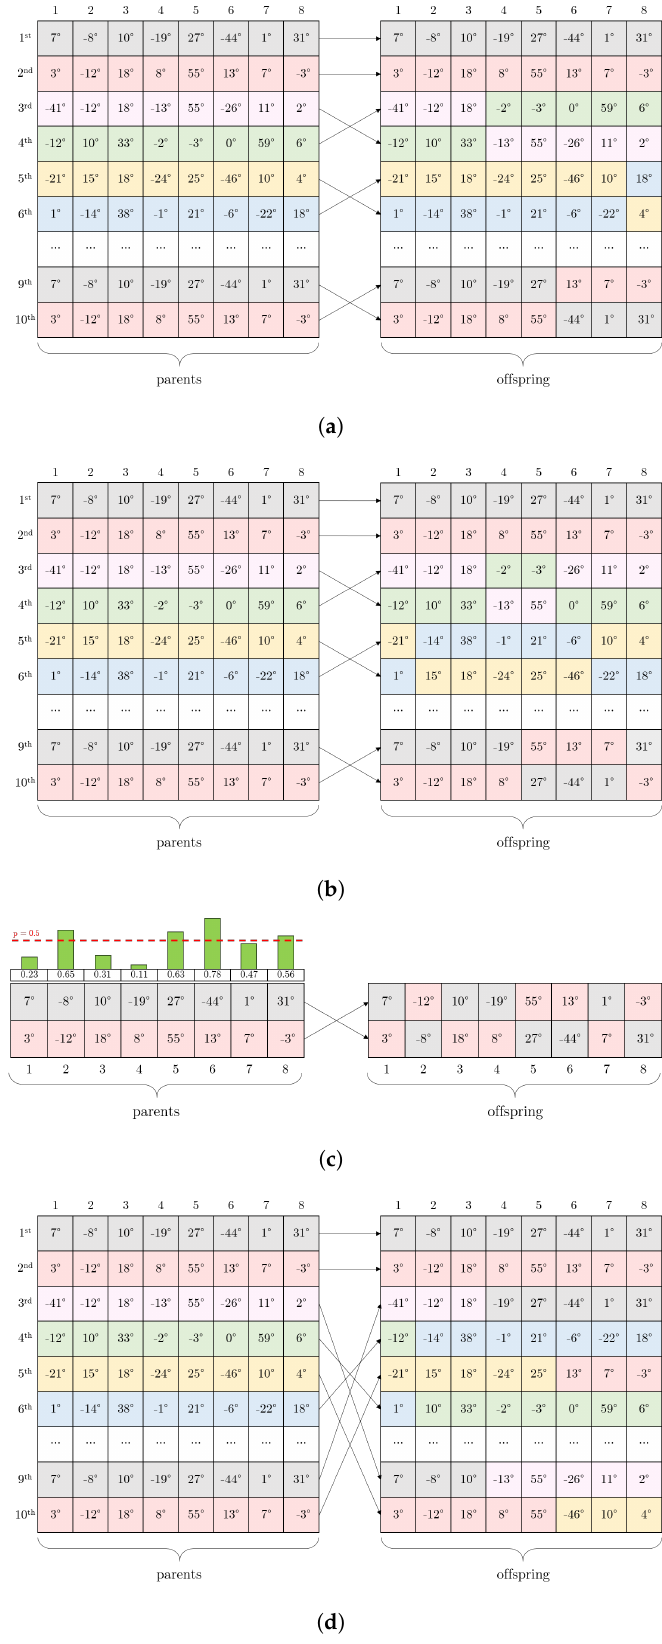
Figure A1. Crossover approaches. ( a ) Single-Point Crossover; ( b ) Double-Point Crossover; ( c ) Uni- form Crossover; ( d ) Single-Random